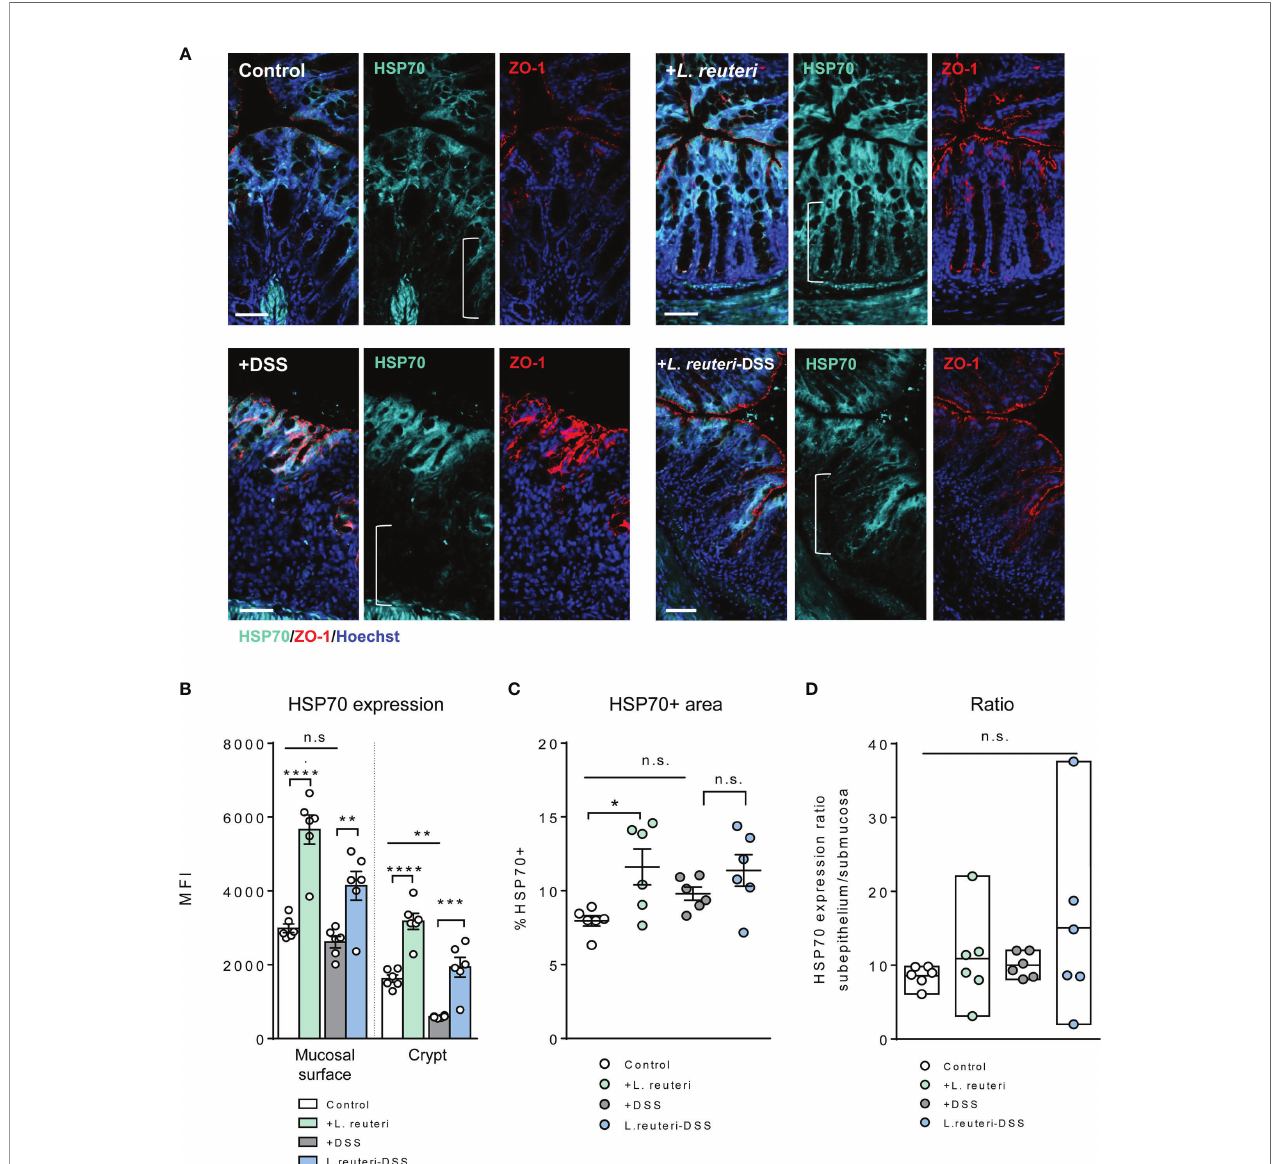
FIGURE 5 | Alterations of HSP70 expression in the colon in response to L. reuteri during DSS-induced colitis in young mice. (A) Representative images of colonic tissue sections stained with antibodies speci fi c for HSP70 (cyan) and ZO-1 (red). Sections were counterstained with Hoechst (blue). Scale bar = 50 m m. (B – D) Analysis and quanti fi cation of HSP70 expression, n = 6 mice per group (duplicate slides per mouse). Data are presented as mean ± SEM. * p < 0.05, ** p < 0.01, *** p < 0.001, and **** p < 0.0001 using ANOVA with Tukey ’ s post-hoc test. DSS, dextran sulfate sodium. ns, non signi fi